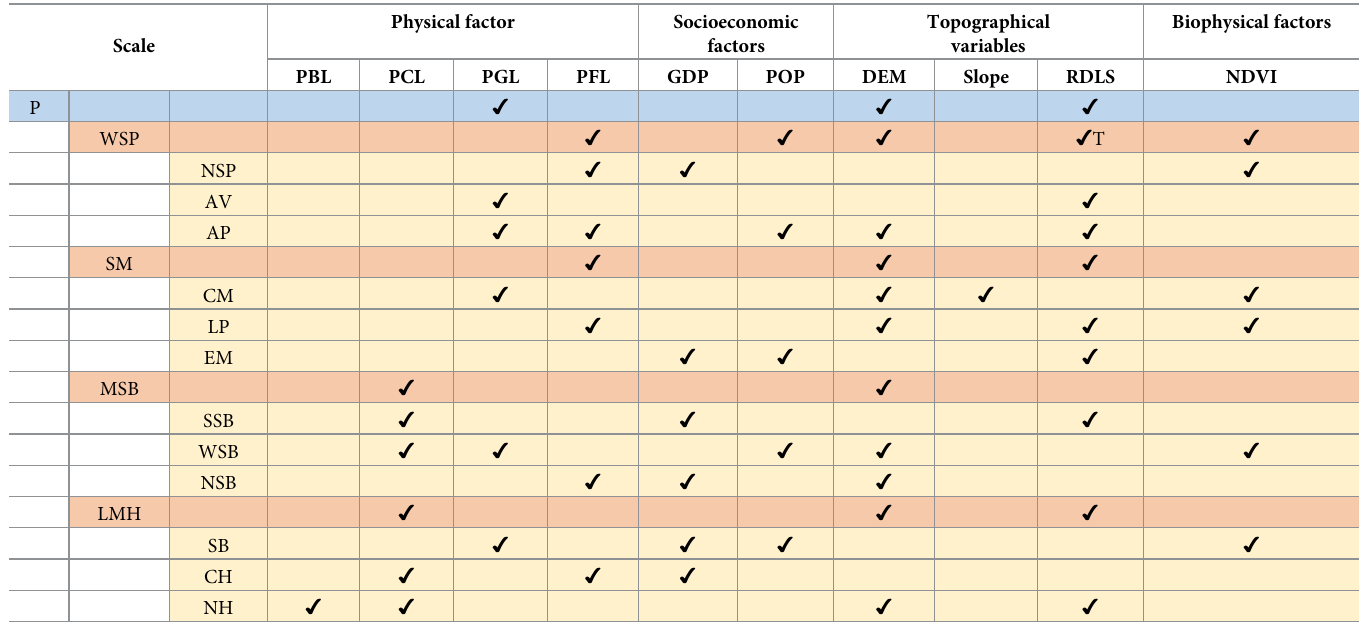
Table 4. The associations between environmental factors and the local regression coefficients of soil conservation at the provincial (P) scale, ecoregion (E) scale, and subecoregion (SE) scale (p < 0.05). Physical factor Socioeconomic Topographical Biophysical factors Scale factors variables PBL PCL DEM Slope RDLS